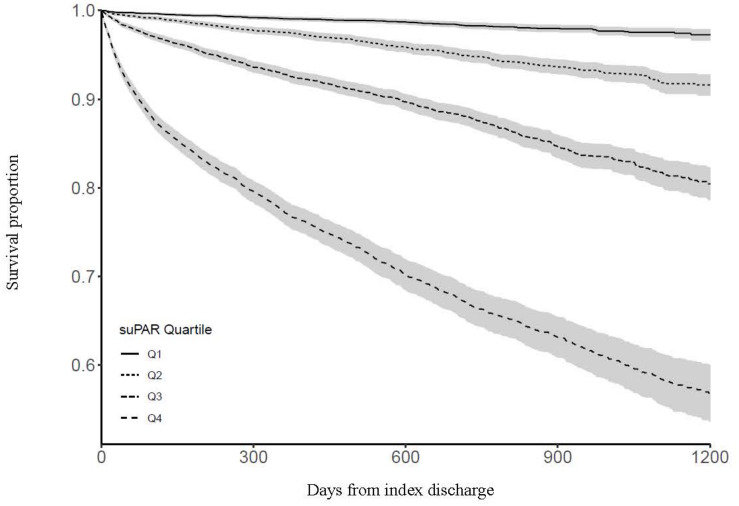
Survival by suPAR quartile. Shaded areas indicate 95% confidence intervals.